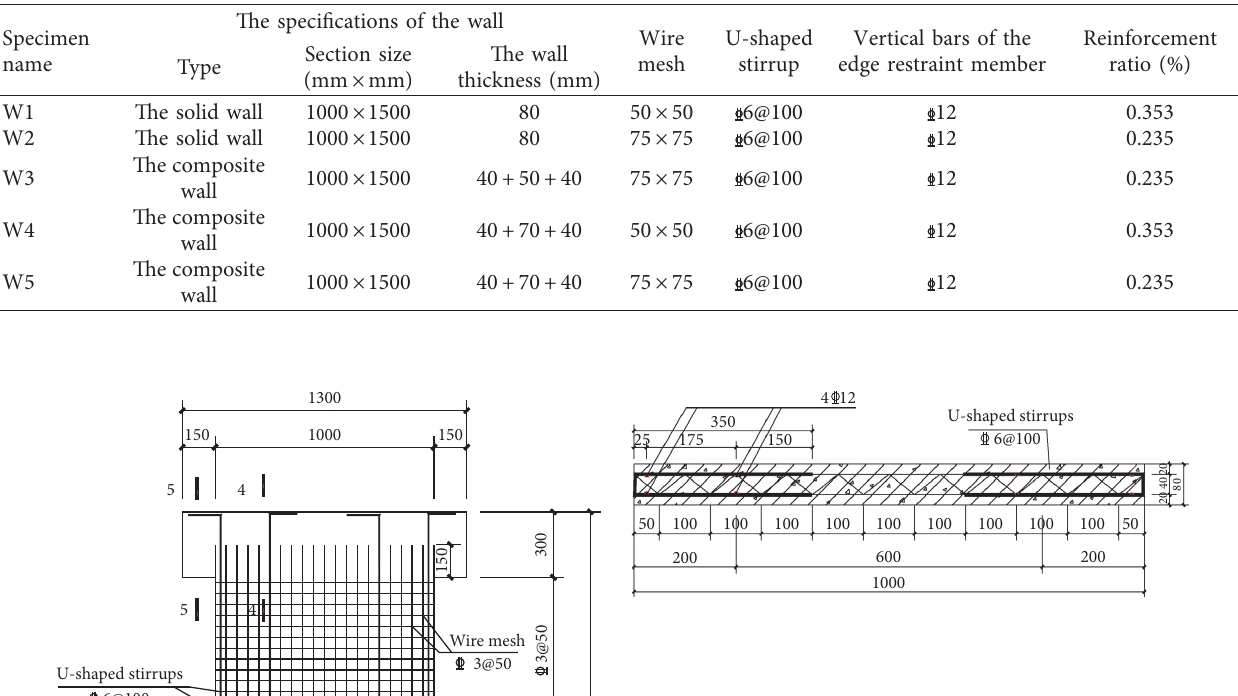
Table 1: Basic parameters of specimen.